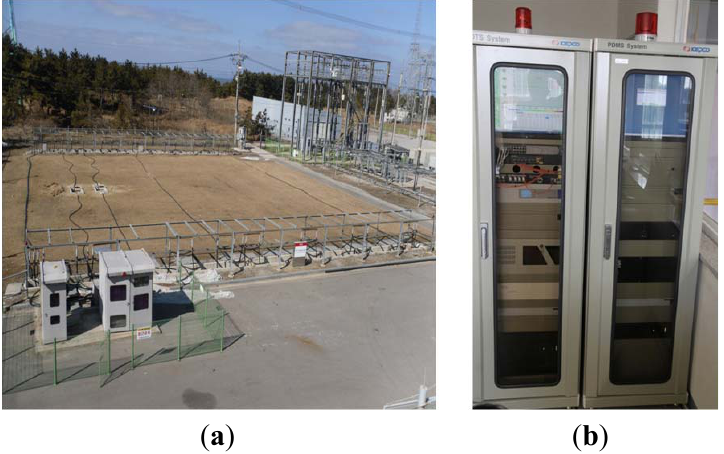
Figure 8. Intelligent cable monitoring system: ( a ) test-bed and ( b ) central